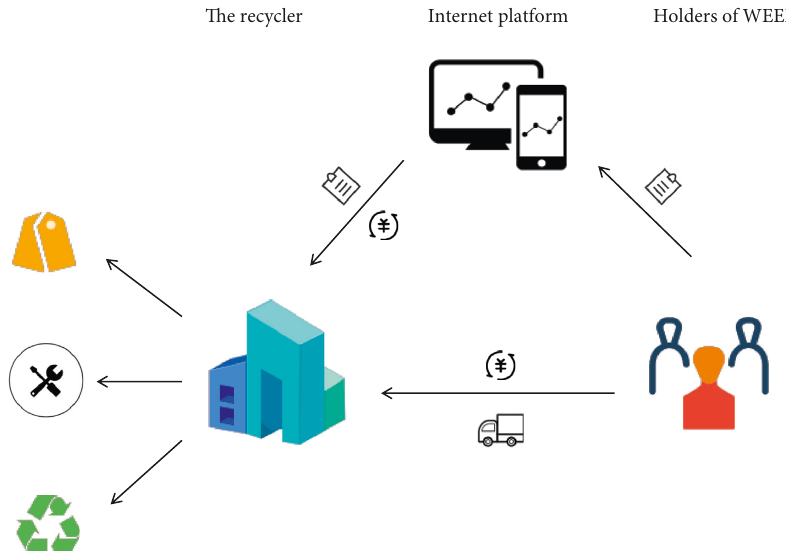
Figure 1: Reverse supply chain with E-platform